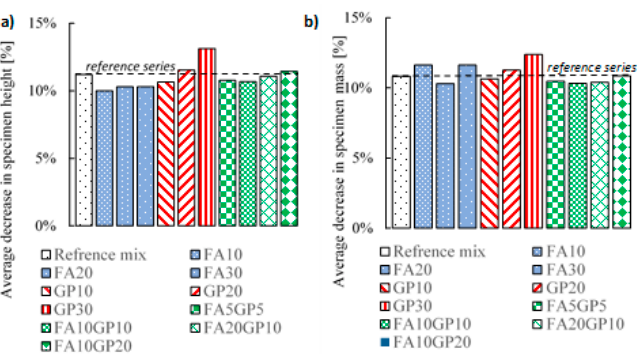
Figure 7. Results presenting the average ( a ) depth of wear and the ( b ) loss of mass for all samples.